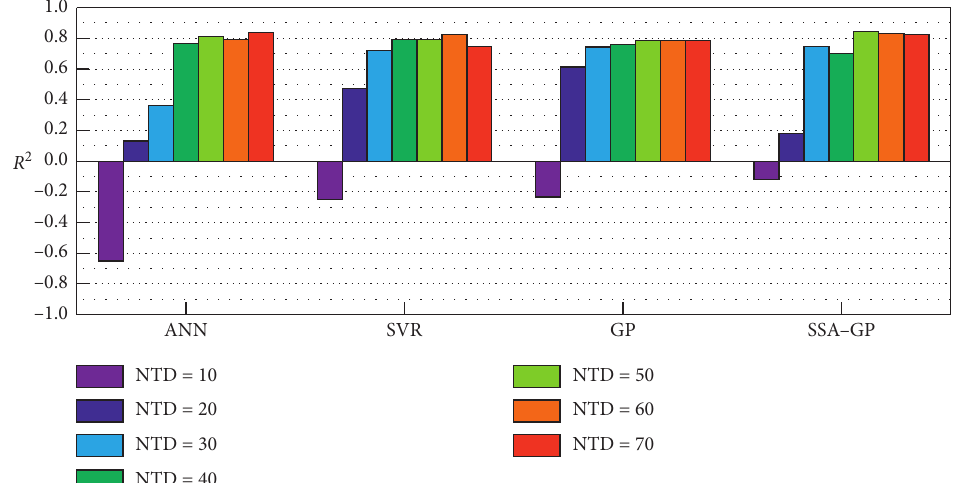
Figure 7: Performance dependency analysis